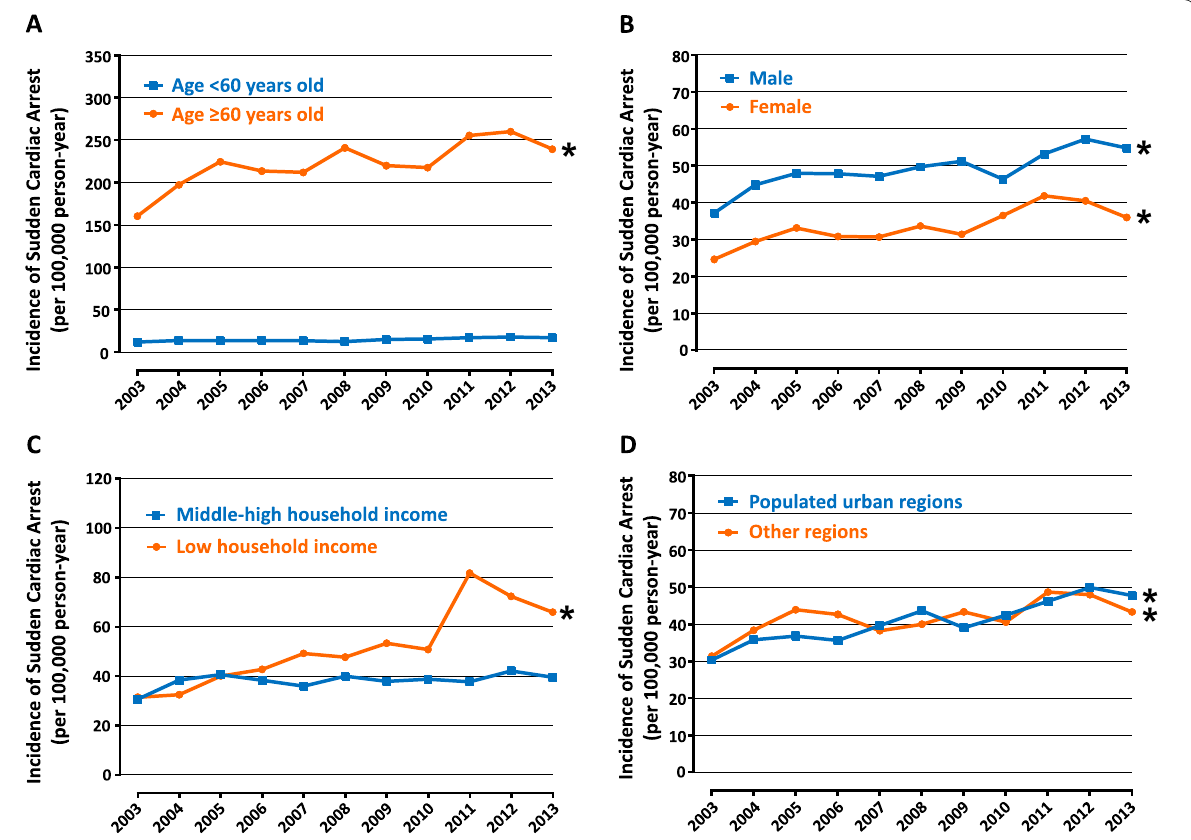
Fig. 2 Annual incidence of sudden cardiac arrest per 100,000 persons according to the age ( a ), Gender ( b ), Household income ( c ), and Region ( d ) from 2003 to 2013. All annual incidences were adjusted for the age and gender. * p